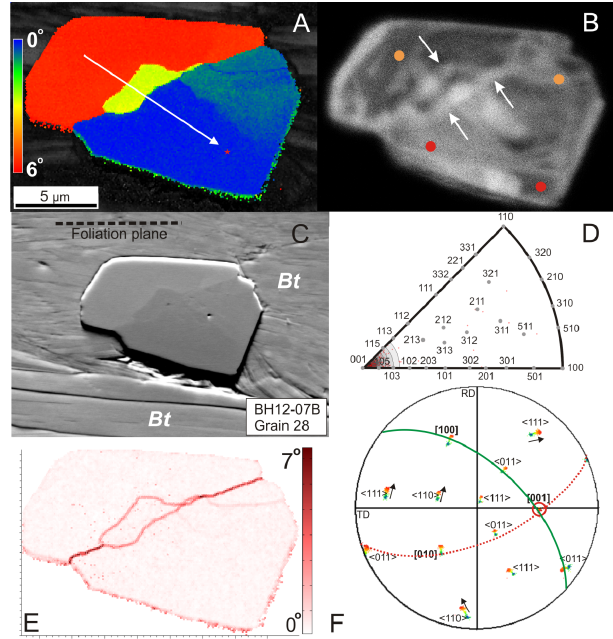
Figure 4. Grain BH12-07B_28, lattice distortion type (III) case 2. (a) EBSD map color-coded for zircon misorientation with respect to a reference point (red star marker). The white arrow corresponds to the misorientation profile shown in Fig. 13c. (b) CL image; the bright lines (marked by white arrows) correspond to the subgrain boundaries; colored points represent relative degree of crystallinity; color coding is as in Fig. 2b. (c) Forward-scattered electron (FSE) image; Bt: biotite. (d) Inverse pole figure plot with the distribution density of misorientation axes shows concentration around zircon [001]. (e) EBSD map of zircon showing the misorientation between neighboring data points. (f) Pole figure plot showing zircon crys- tal directions (lower-hemisphere equal area projection) color-coded as in (a) . Labels indicate the crystallographic directions. Black ar- rows show scattering of axes due to rotation about zircon [001] (red circle). The dashed red line shows the orientation of the subgrain boundary, and the solid green line indicates the slip plane orienta-